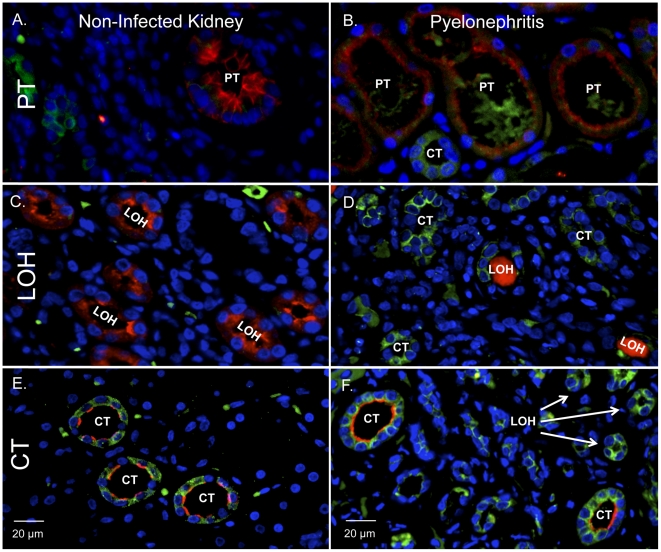
Tubular HD5 expression in states of sterility and infection.Human kidney labeled for HD5 (green), nuclei (blue) and nephron specific markers (red). Segment markers consisted of AQP-2 for collecting tubules (CT), THP for the loop of Henle (LOH), and AQP-1 for proximal tubules (PT). A/B: HD5 (green) was produced in the collecting tubules (red apical AQP-2 staining) of non-infected kidney tissue (A) and with pyelonephritis (B). Arrows indicate HD5 is produced in other nephron segments. C/D: HD5 (green) was expressed in the loops of Henle (red THP staining) in non-infected kidney tissue (C) and with pyelonephritis (D). E/F: HD5 (green) shows minimal production in the proximal tubules (red AQP-1 staining) of non-infected kidney tissue (E) and with pyelonephritis (F). Magnification 40×.